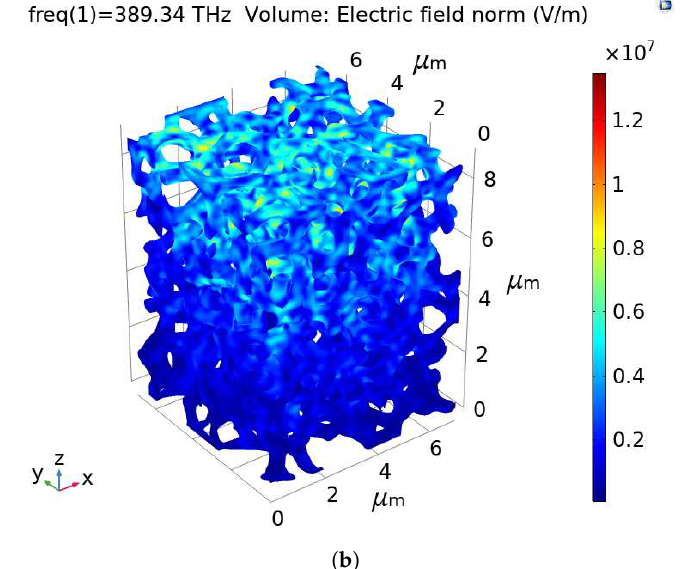
Figure 10. Illustration of the EFN ( a ) in the cutaway view and ( b ) on the surface of the porous mode.